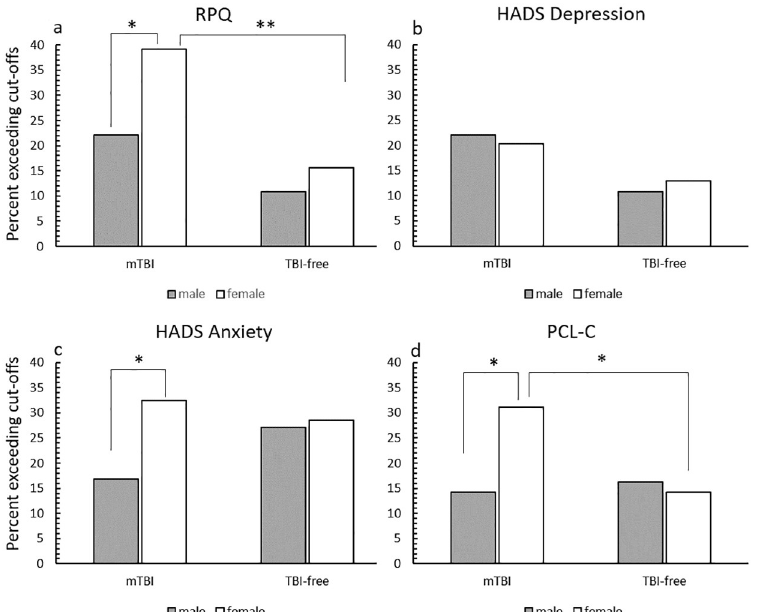
Fig 2. The percentage of participants in the mTBI and comparison group meeting the cut-off scores for the RPQ (a), HADS depression (b), HADS anxiety (c) and PCL-C (d) Note: Data are presented as the percentage of the group meeting the cut-off score. N for mTBI group = 151 (males = 77, females = 74); N for TBI free group = 151 (males = 74, females = 77). The cut-off for the RPQ was 4 or more items with a rating > 2; the cut-off score for the HADS was � 8 and the cut-off score for the PCL-C was � 14. � p < .05 �� p < .01 from chi-square